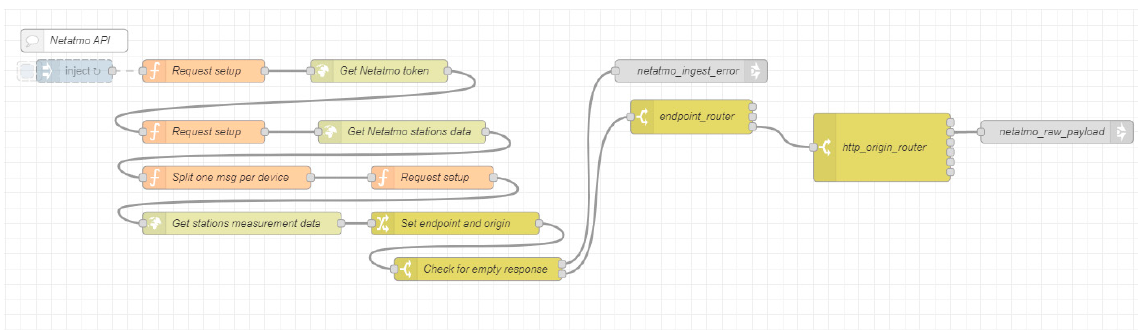
Figure 7. Node-RED flow—Payload sanitizing of Netatmo weather station. The final stage of the data ingest model is the decoding of the data before being stored in InfluxDB. This flow can be seen in Figure 8.